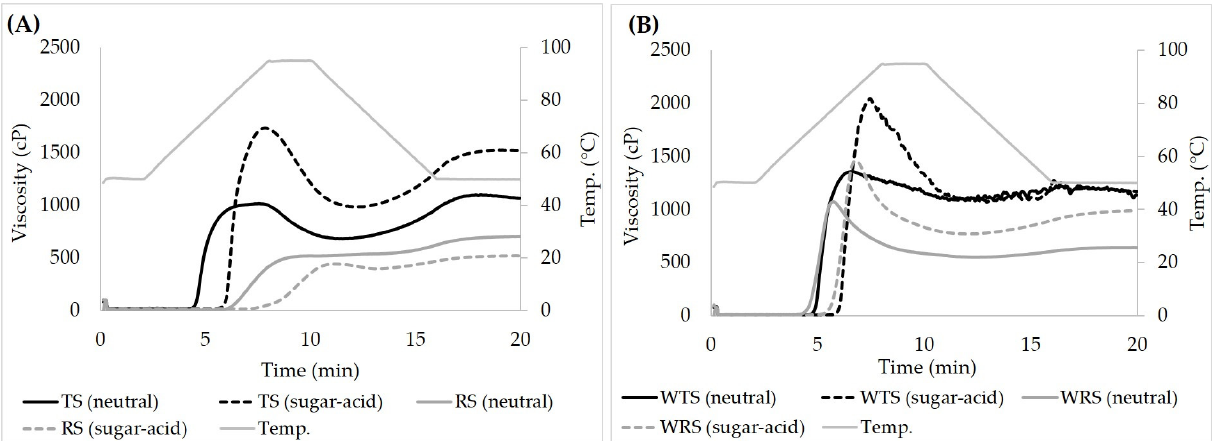
Figure 4. Pasting properties of native starches: ( A ) normal starches and ( B ) waxy starches (starch concentration: 6% w / v ). The solid lines and dashed lines represent starch pasting in distilled water and sugar–acid solution, respectively.